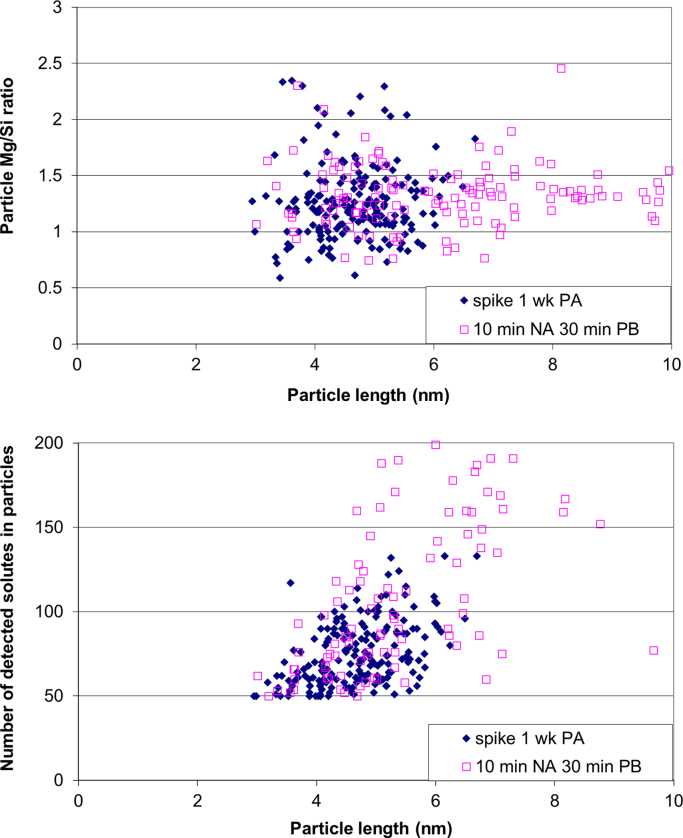
Particle Mg/Si ratio or number of detected solute atoms in particles plotted against particle length after a spike and 1 week PA (blue) or 10 min NA and 30 min PB (pink) as measured by LAR-3DAP. Only particles consisting of 50 solute atoms or more are taken into account. The particle sizes and compositions were obtained using a Nmin of 10 for particle analysis.